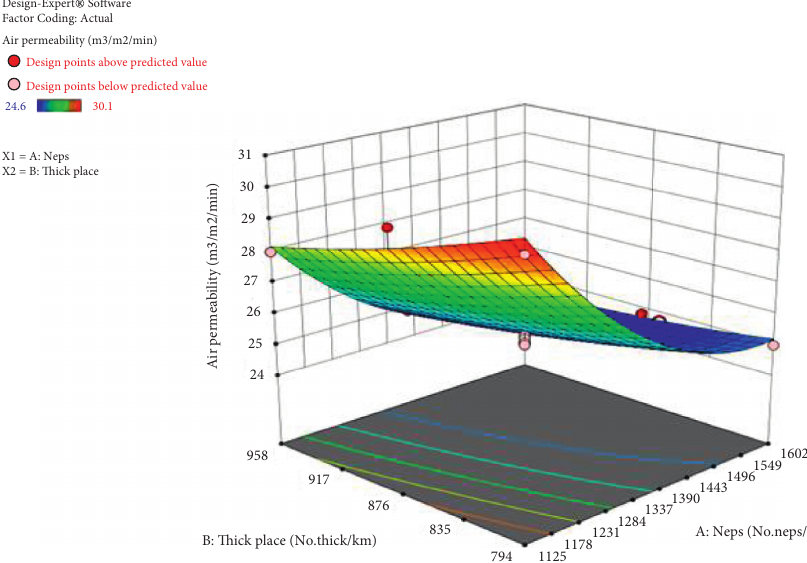
Figure 5: The regression model of the response with two factors.